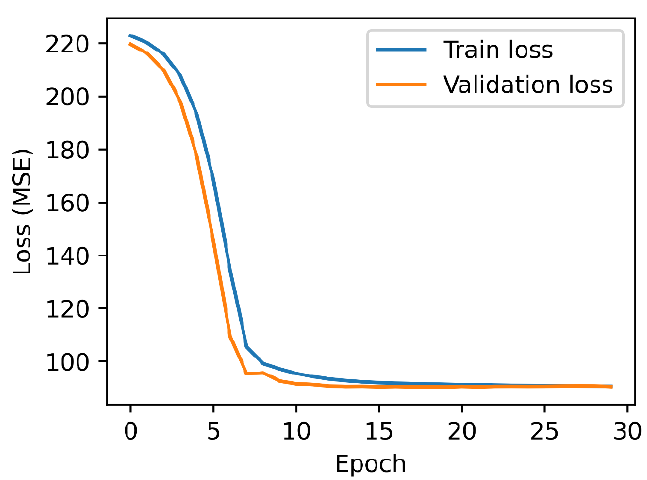
Figure 5. Schematics of the neural network used in this study.